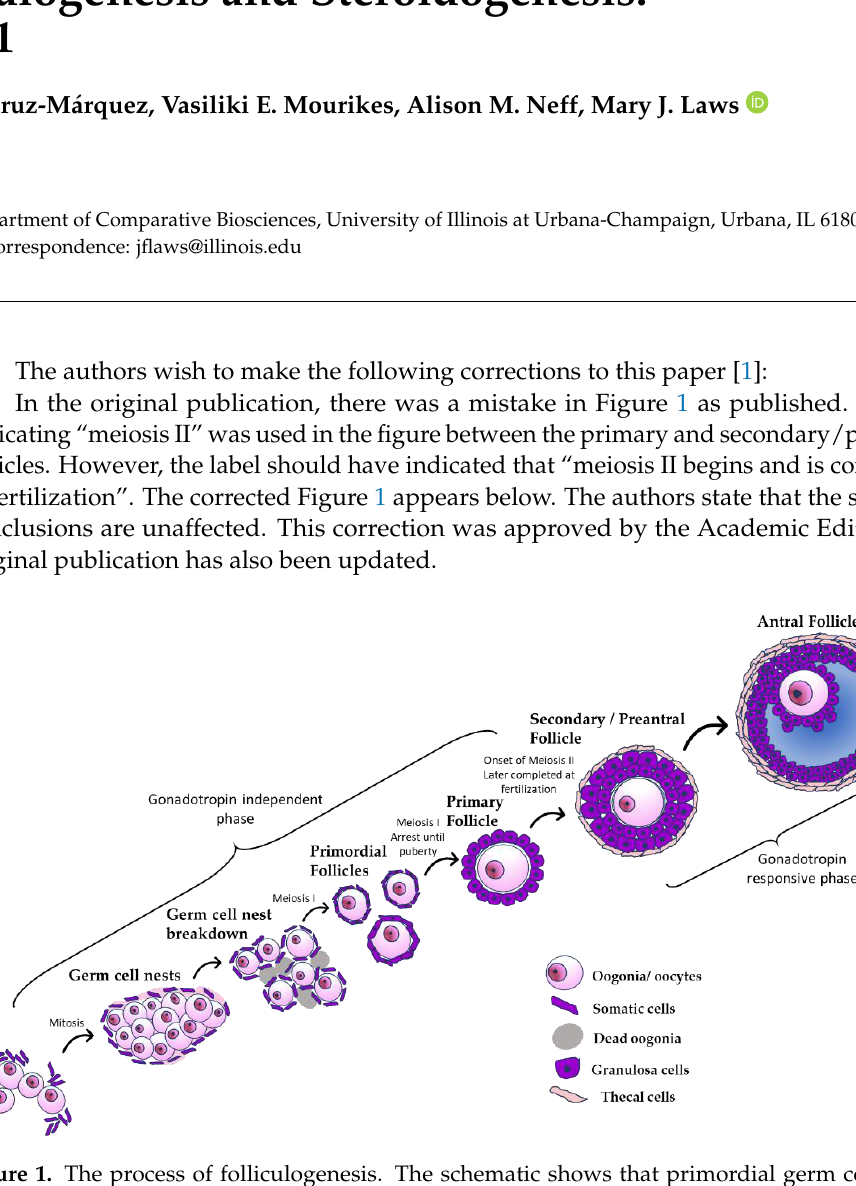
Figure 1. The process of folliculogenesis. The schematic shows that primordial germ cells form germ cell nests, which subsequently break down to form a finite pool of primordial follicles, starting the process of folliculogenesis. During folliculogenesis, primordial follicles grow and mature into primary follicles, then preantral follicles, and finally antral